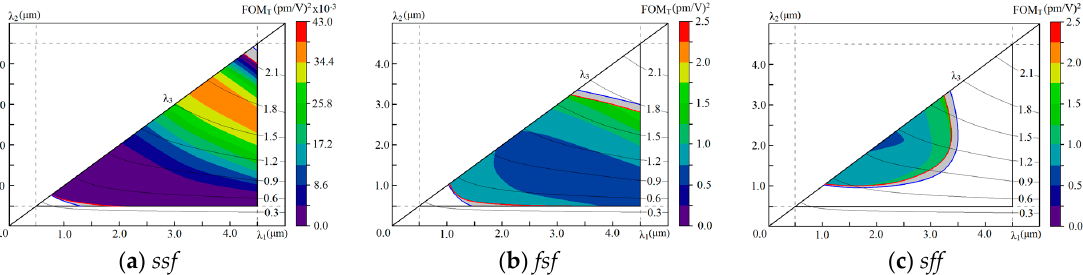
Figure 13. FOM T ( λ 1 , λ 2 ) distributions for RTP crystal for all types of interactions: ( a ) ssf , ( b ) fsf , ( c ) sff .